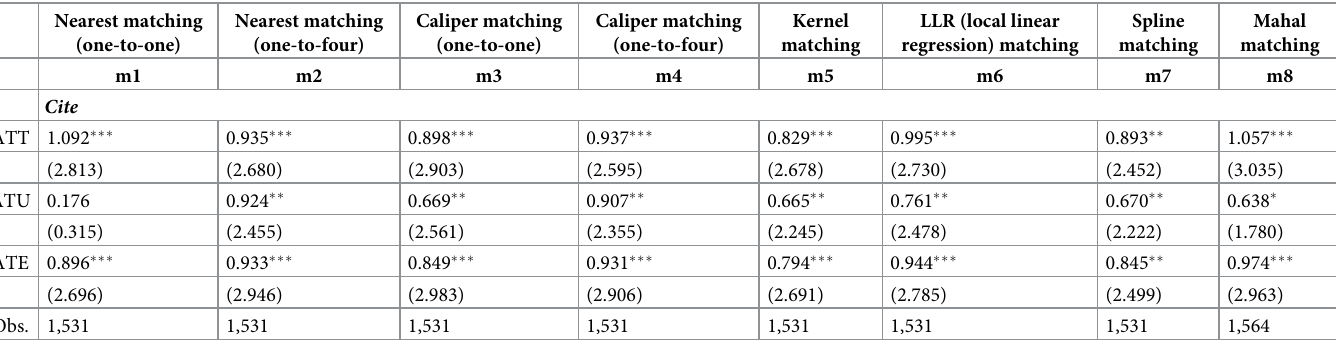
Table 5. Propensity matching score approach. Nearest matching Nearest matching (one-to-one)